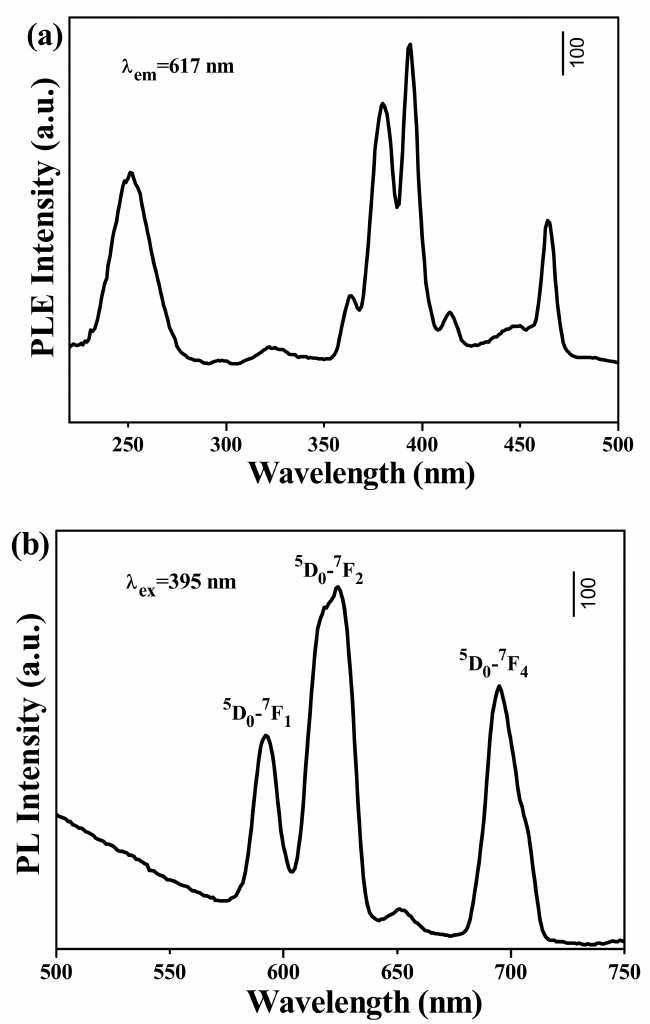
Figure 8. ( a ) PLE and ( b ) PL spectra for MC at room